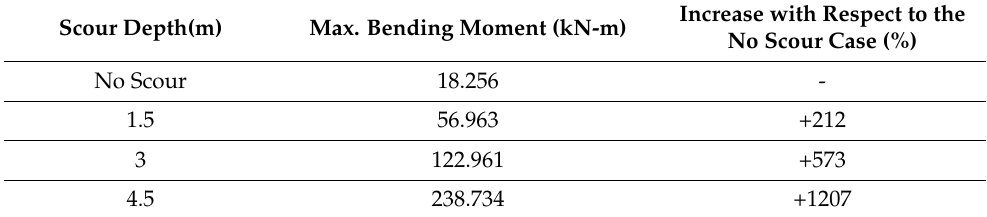
Increase with Respect to the No Scour Case (%)